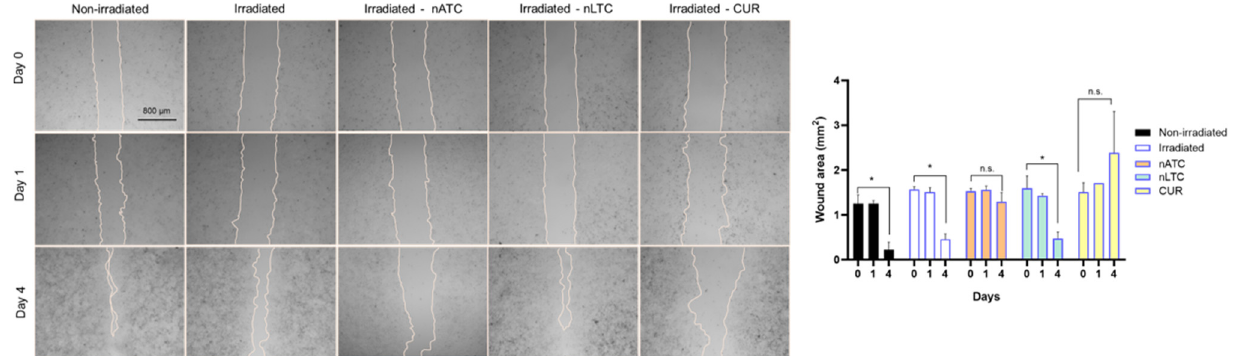
Figure 9. Effect of PDT on cell migration. A549 cells were grown to total confluence and a wound was produced with a tip (day 0). Then cells were treated with nATC, nLTC, or CUR at 5 μ M and irradiated (fluence of 9 J/cm 2 ). After 24 h, cells were washed with PBS (day 1) and fresh medium was added, then cells were incubated for another 72 h (day 4). Images were obtained with bright filed microscopy at Days 0, 1, and 4. Significant differences in wound area compared with non- irradiated control were determined using a one-way ANOVA followed by Dunnet’s test, * p < 0.05; n.s. represents non-significant ( p > 0.05).